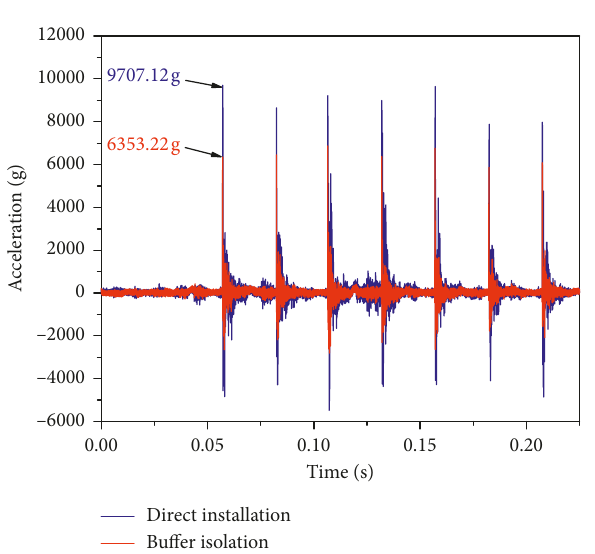
Figure 5: Comparison of the impact